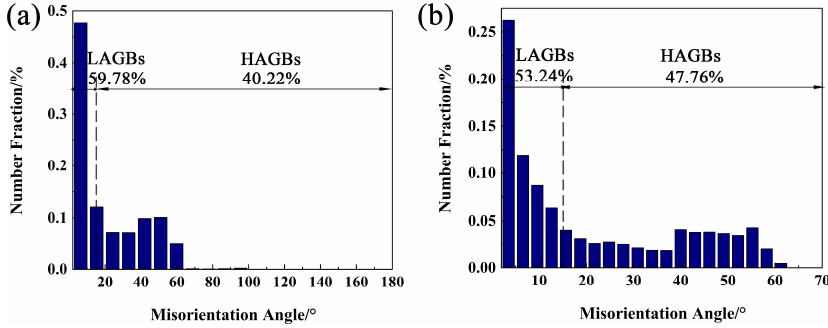
Figure 10. Misorientation Angle (°): ( a ) 380 °C/0.001 s –1 , ( b ) 440 °C/0.001 s –1 .